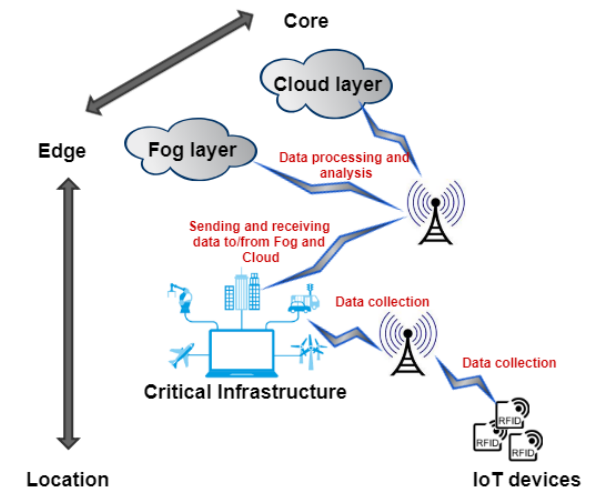
Figure 2. Fog-enabled IoT